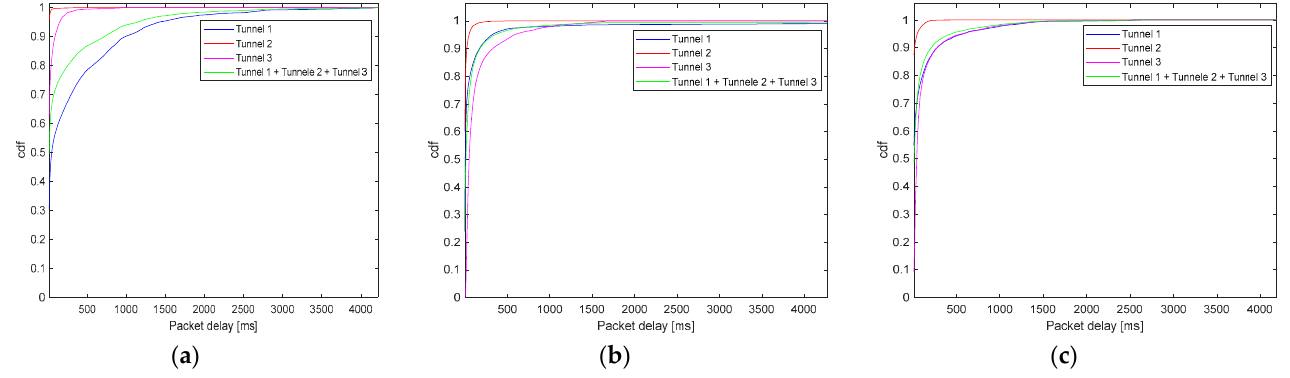
Figure 17. The Cumulative Density Functions of the packet delays on the aggregated virtual tunnels when 3APs and different user clustering algorithms are used: ( a ) The cdfs of the packet delays when no user clustering algorithm is used; ( b ) The cdfs of the packet delays when the cooperative user clustering algorithm with 1 dB power adjustment step is used; ( c ) The cdfs of the packet delays when the cooperative user clustering algorithm with 2 dB power adjustment step is used.